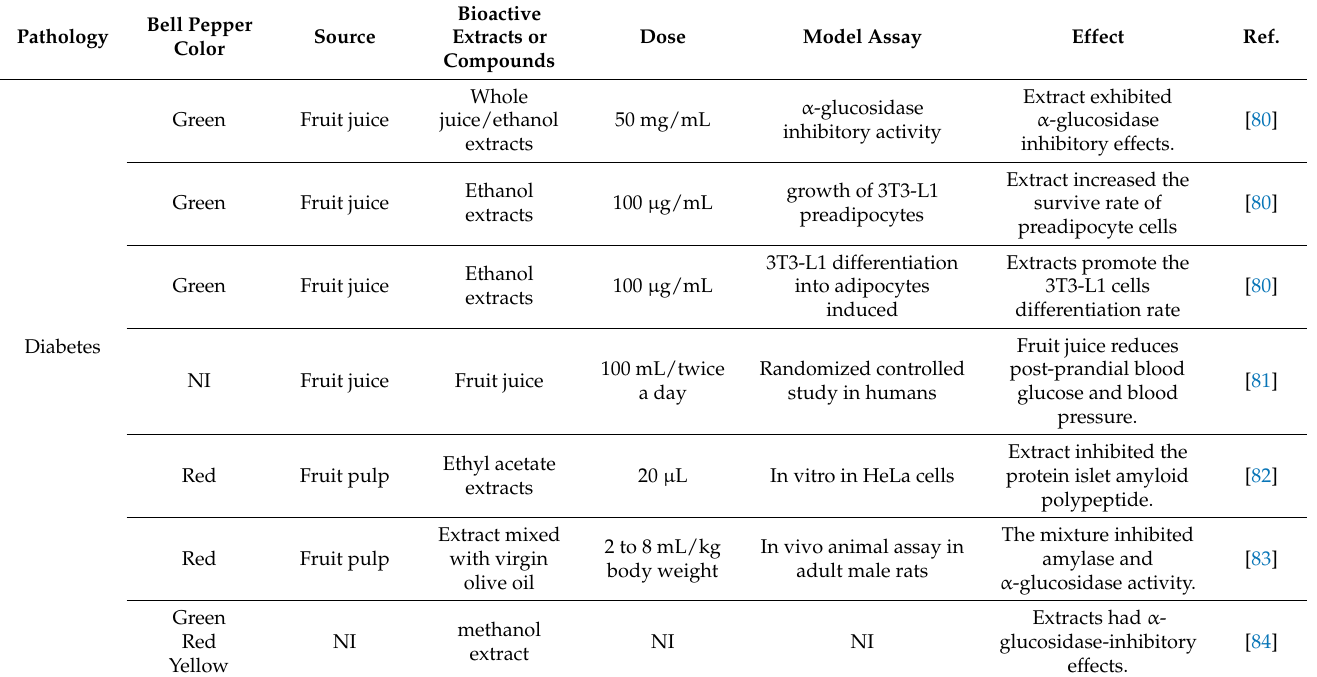
Table 7. Effects of bell pepper extracts on diverse